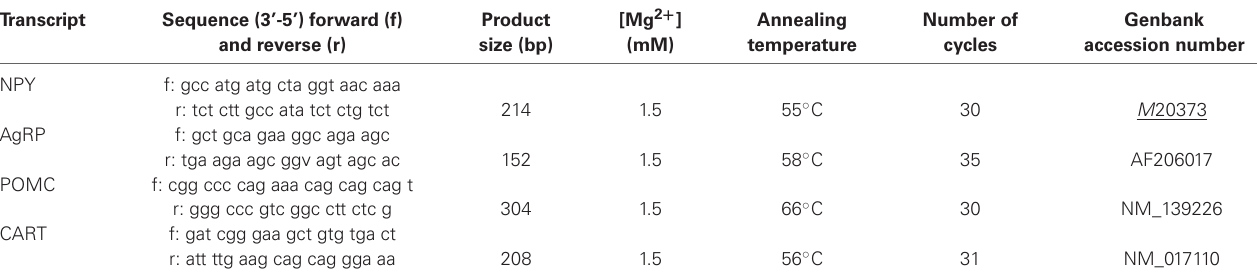
Table 1 | PCR parameters for amplification of NPY, AgRP, POMC, CART mRNAs under basal conditions.